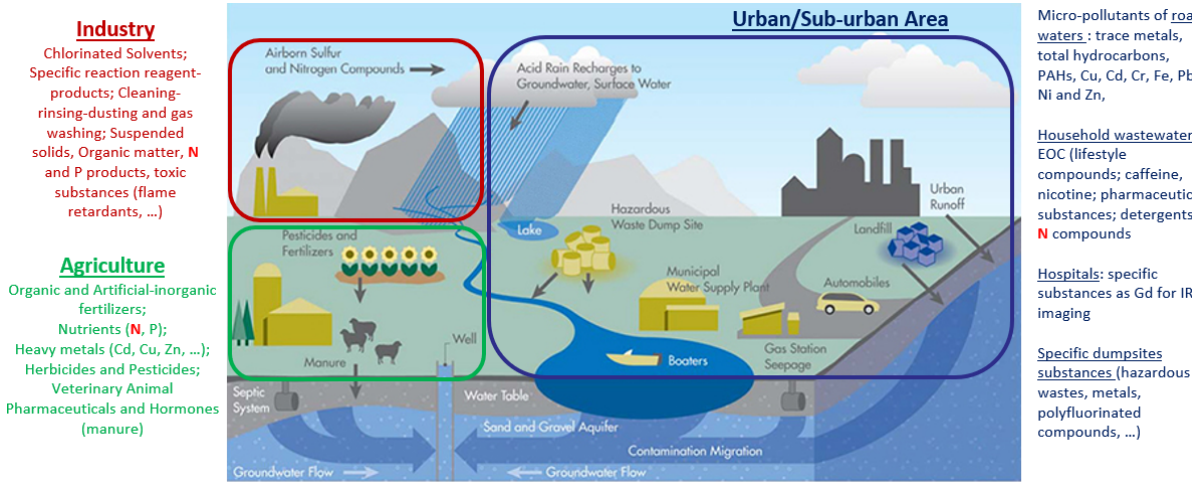
Figure 2. Schematic synthesis of sub/urban contamination: pollutants and sources (modified by Peterson et al., 2007, from the link https: //www.mrgscience.com/ess-topic-44-water-pollution.html, last access: 18 October